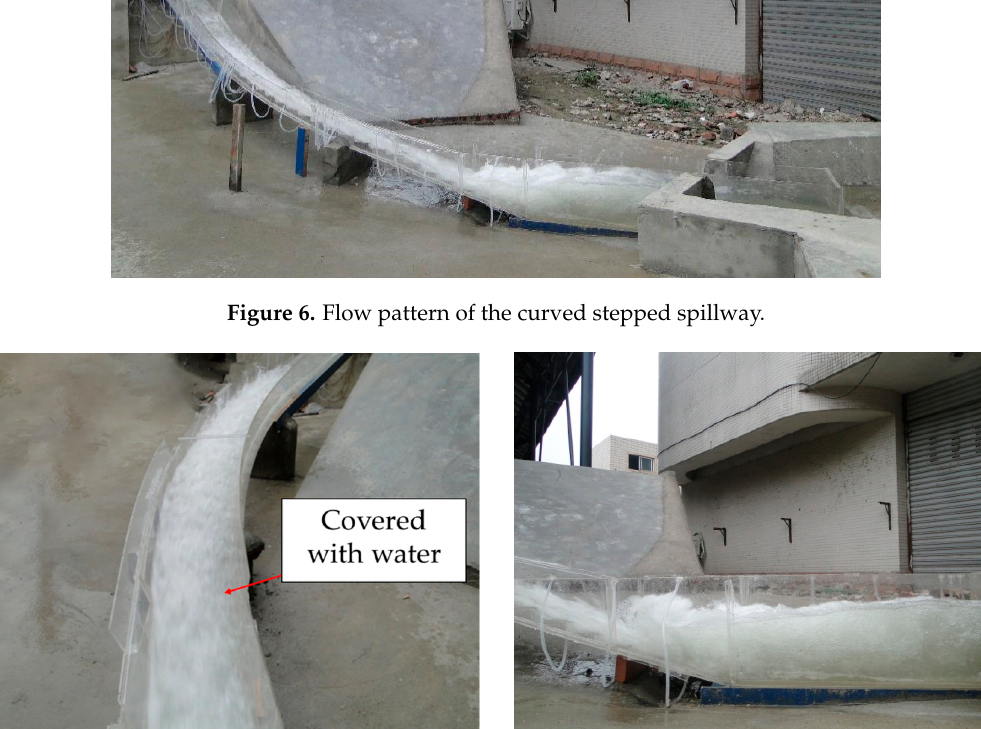
( a ) Curved section. ( b ) Stilling basin. Figure 7. Flow regime in the curved section and stilling basin of the stepped spillway. Table 2. The average water depths of each measuring point at a flow discharge rate of 272.0 m 3 /s of the prototype.